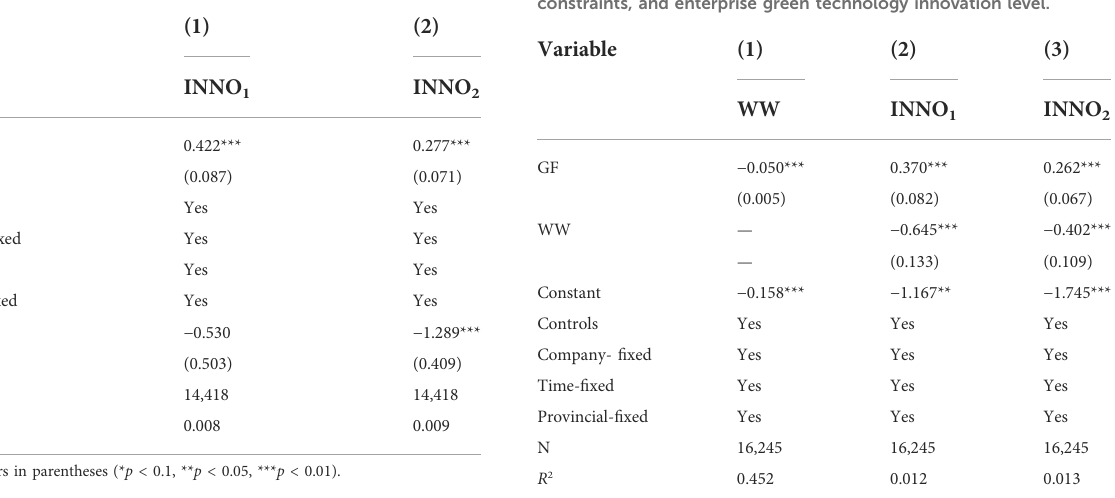
TABLE 6 Robustness test: Sample excluding the data of 2017.